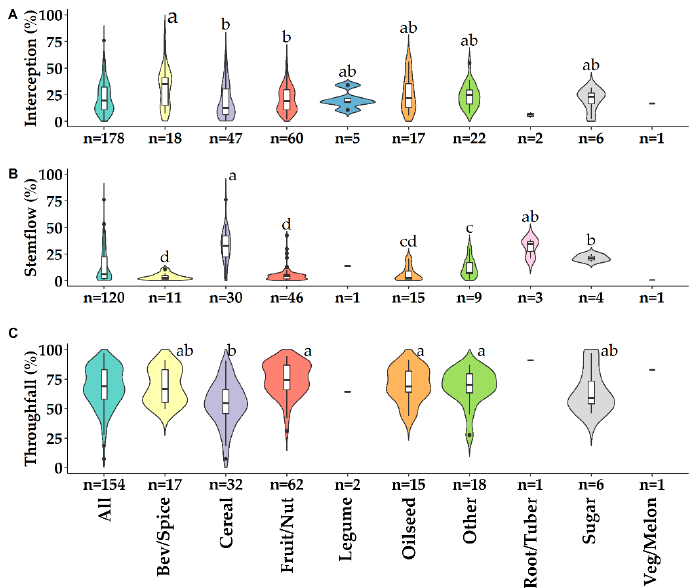
Figure 2. Violin plots of observed relative ( A ) interception, ( B ) stemflow, and ( C ) throughfall normalized per amount of rainfall or sprinkler-irrigation and grouped by the UN-FAO crop product types. Symbols indicate the median (horizontal line), interquartile range (box), non-outlier range (vertical line), outliers (dots), and probability density (violin). Where sample sizes were large enough per group to develop a probability density function, Kolmogorov–Smirnov tests assessed di ff erences in probability distributions (Table S2 in Supplemental Materials) and alphabetical superscripts indicate significant di ff erences ( p <